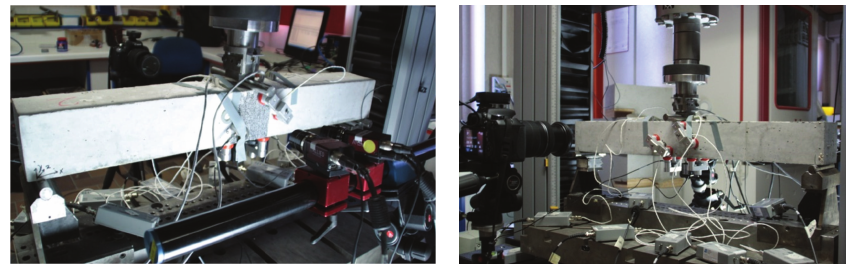
Figure 4: View of experimental setup configuration.